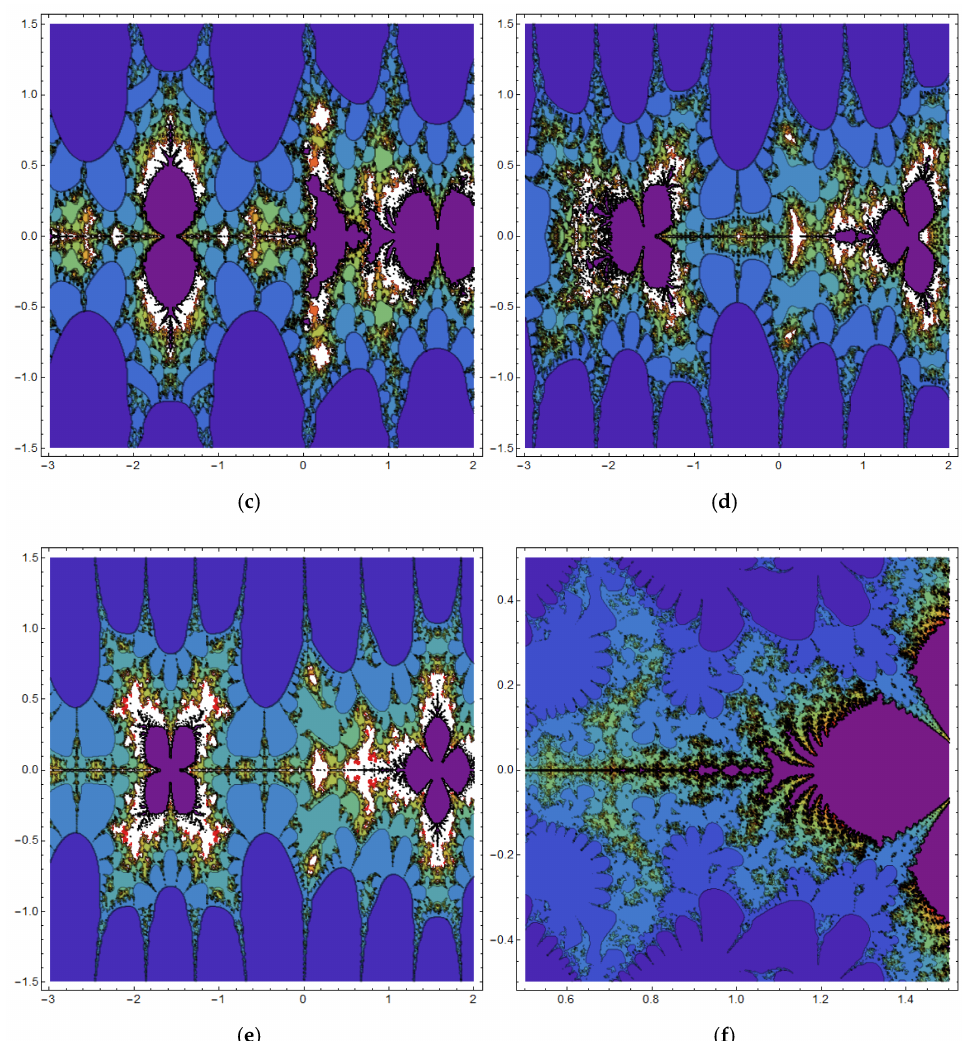
Figure 5. The Mandelbrot sets generated by the generalized fractional cosine map at α = 0.5, where